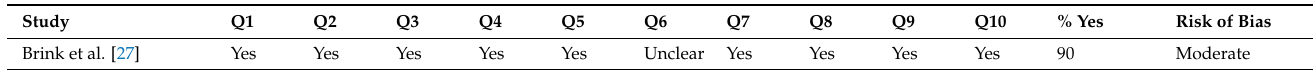
Table 6. Risk of bias assessment for case series studies according to the JBI tool [34].